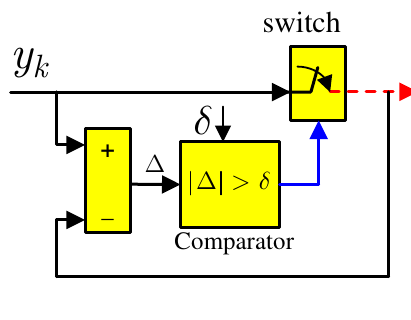
Figure 3. Send-on-delta sampling in discrete-time